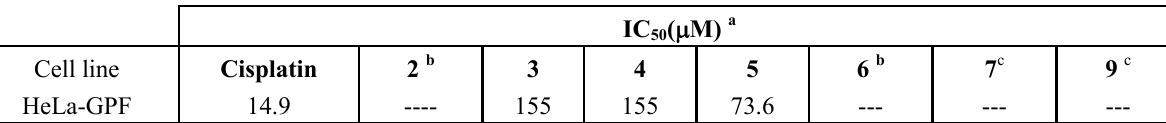
values for HeLa-GPF cells of compounds 3 - 7 and ligand 2 [10] and complex Table 4. IC 50 9 [10], compared to